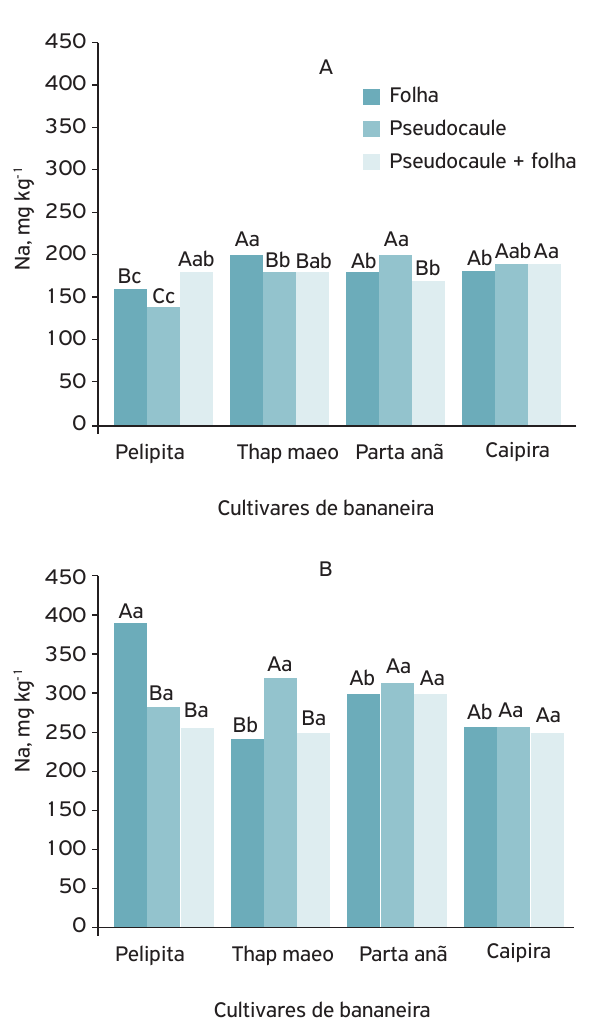
Figura 1. Teores de Na, mg kg -1 , presente no substrato à base de resíduos de bananeira (pseudocaule, folha e pseudocaule + folha) de quatro cultivares de bananeira (Thap maeo, Prata anã, Pelipita e Caipira) antes (A) e após 49 dias (B) de colonização pela linhagem 09/100 de Pleurotus ostreatus . Letras maiúsculas comparam médias dentro de um mesmo cultivar de bananeira; letras minúsculas comparam médias dentro de cada tipo de resíduo. Médias seguidas de letras iguais não diferem entre si (Tukey, 5%) (Média de duas